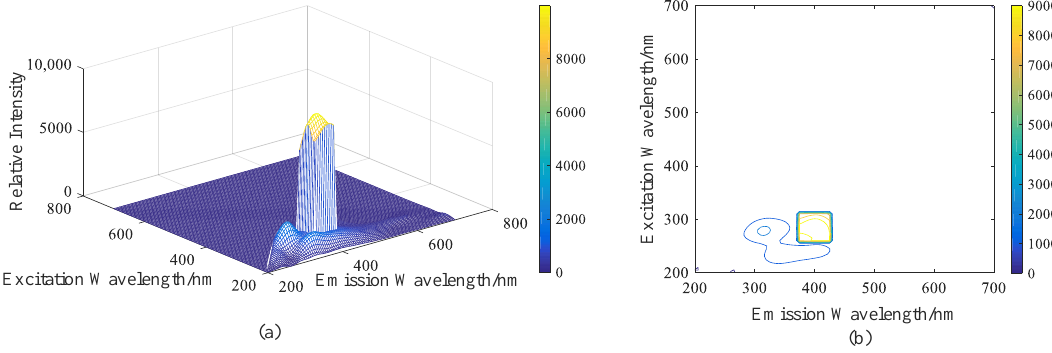
Figure 8. 3D ( a ) and contour ( b ) diagrams of 4 μg/L salicylic acid positioning result.